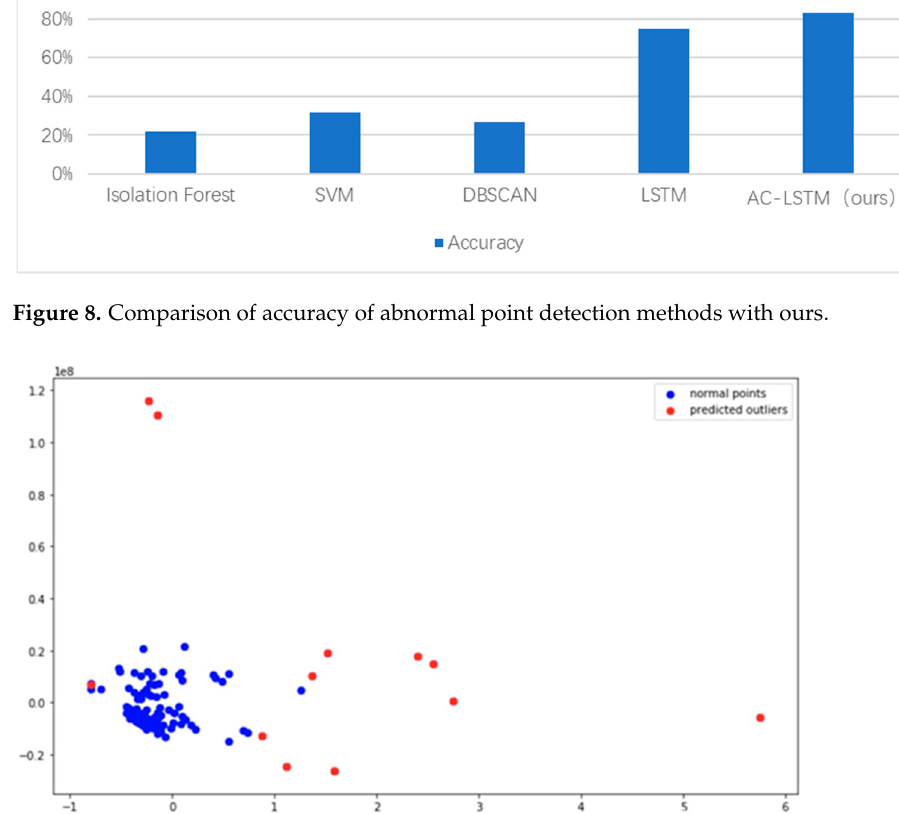
Figure 10. LSTM abnormal score effect.